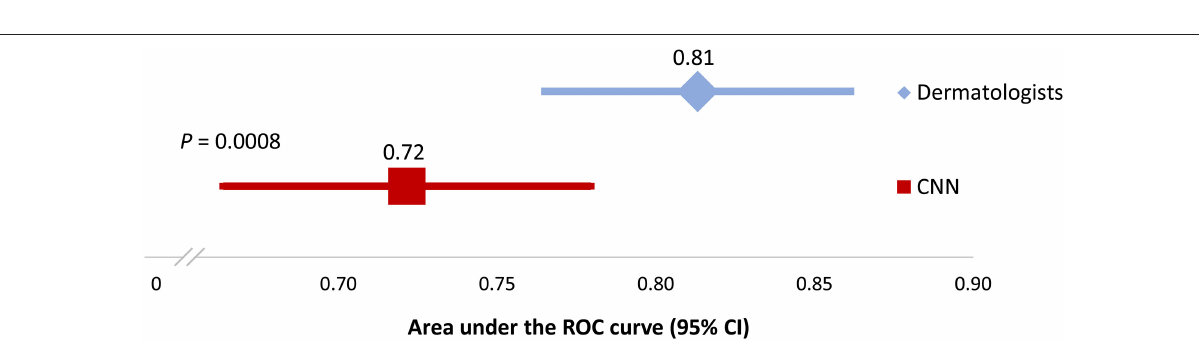
FIGURE 3 | Area under the ROC curve. CNN, convolutional neural network; CI, confidence interval; ROC, receiver operating